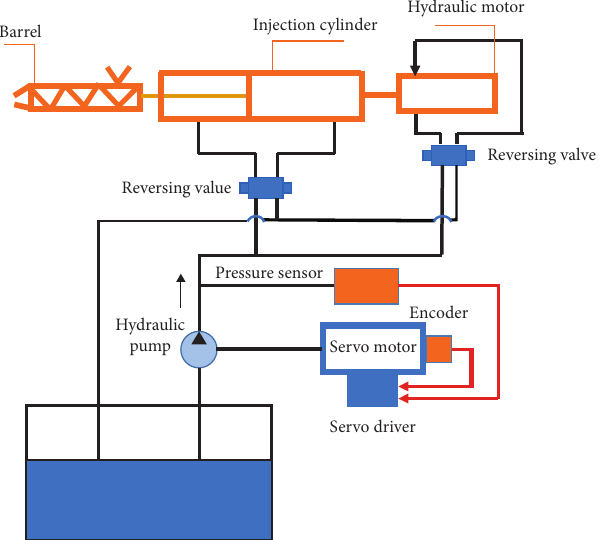
Figure 4: Injection system schematic of Tianlong IAIIS series injection molding machine.